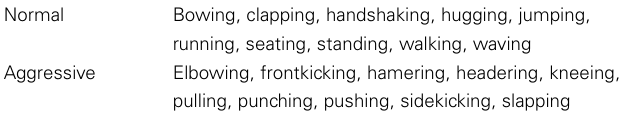
Table 2 | Physical action